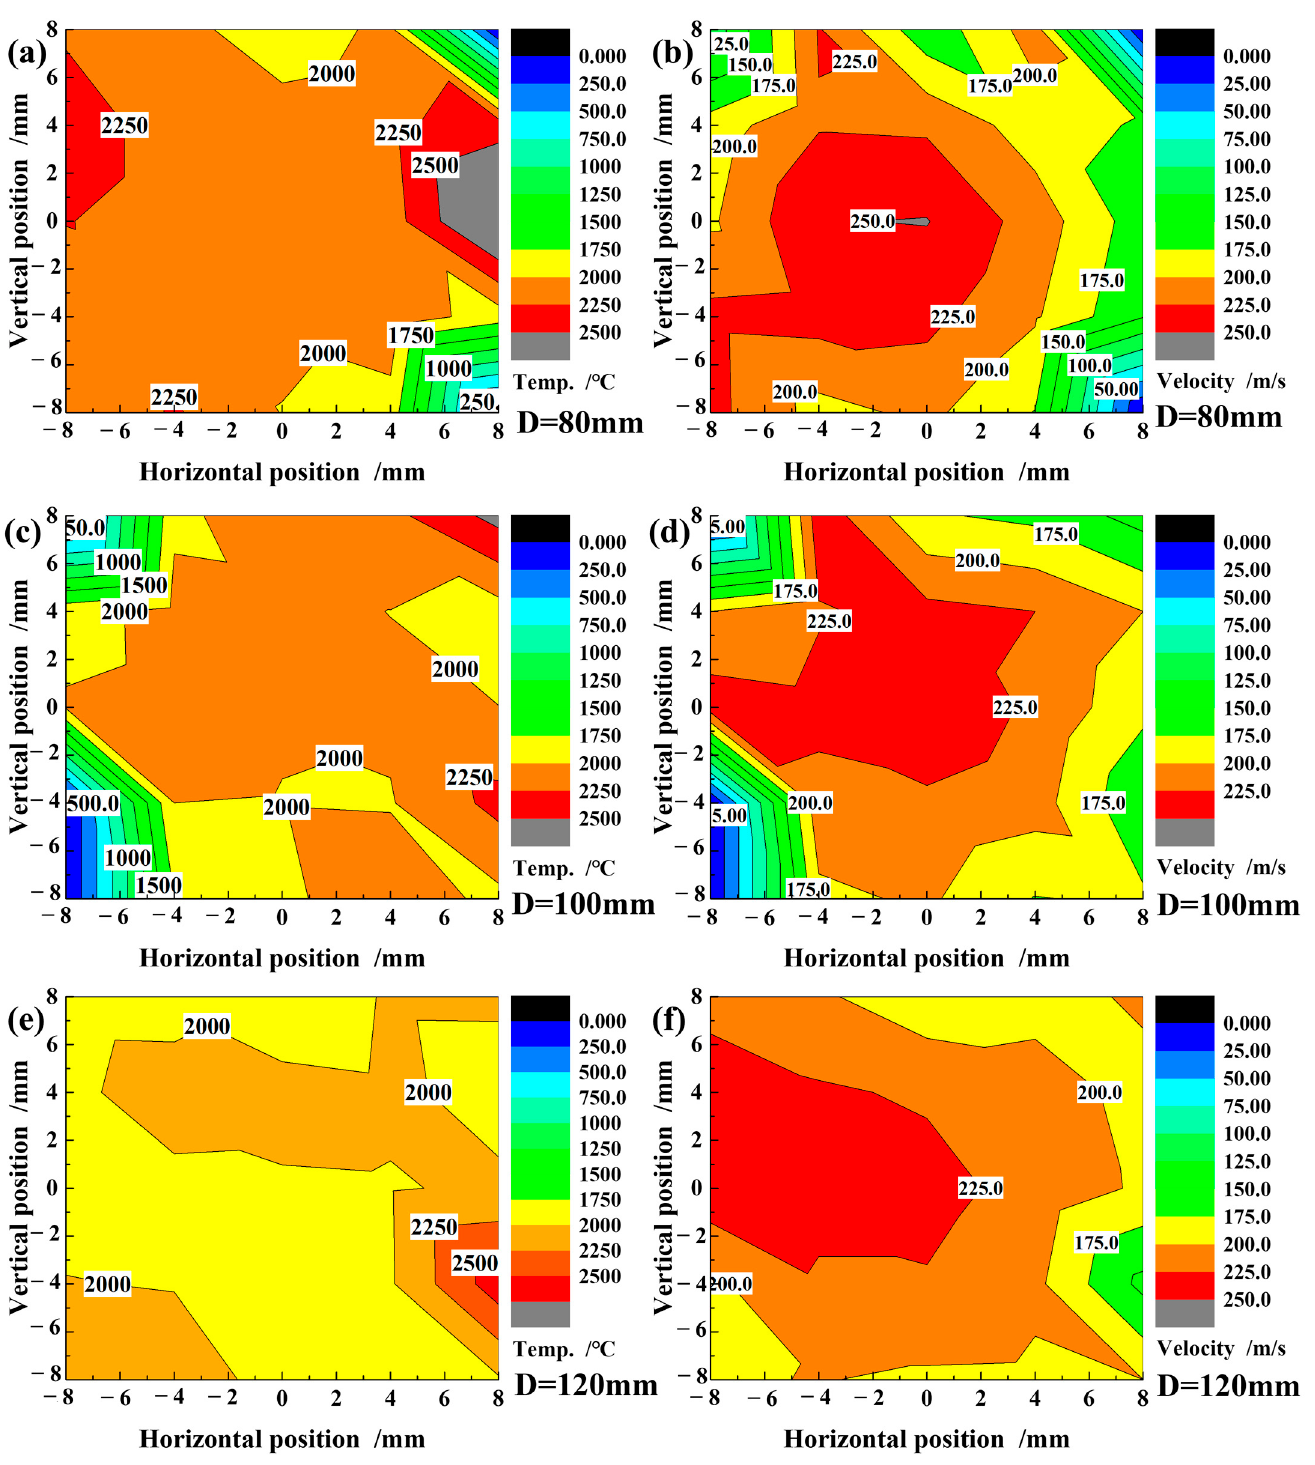
Figure 7. Distribution of temperatures and velocities with different spraying distances: ( a , b ) 80 mm; ( c , d ) 100 mm; ( e , f ) 120 mm.